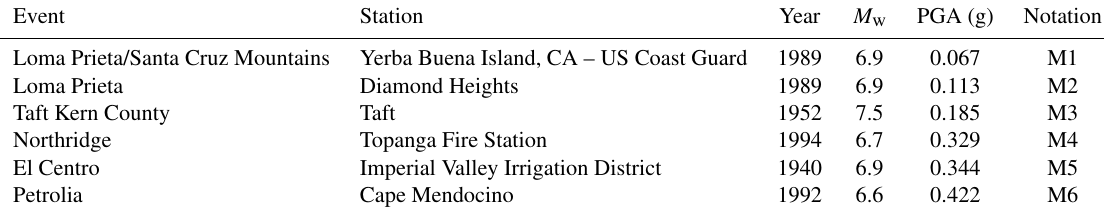
Table 3. Selected strong motion records for ground response analysis.